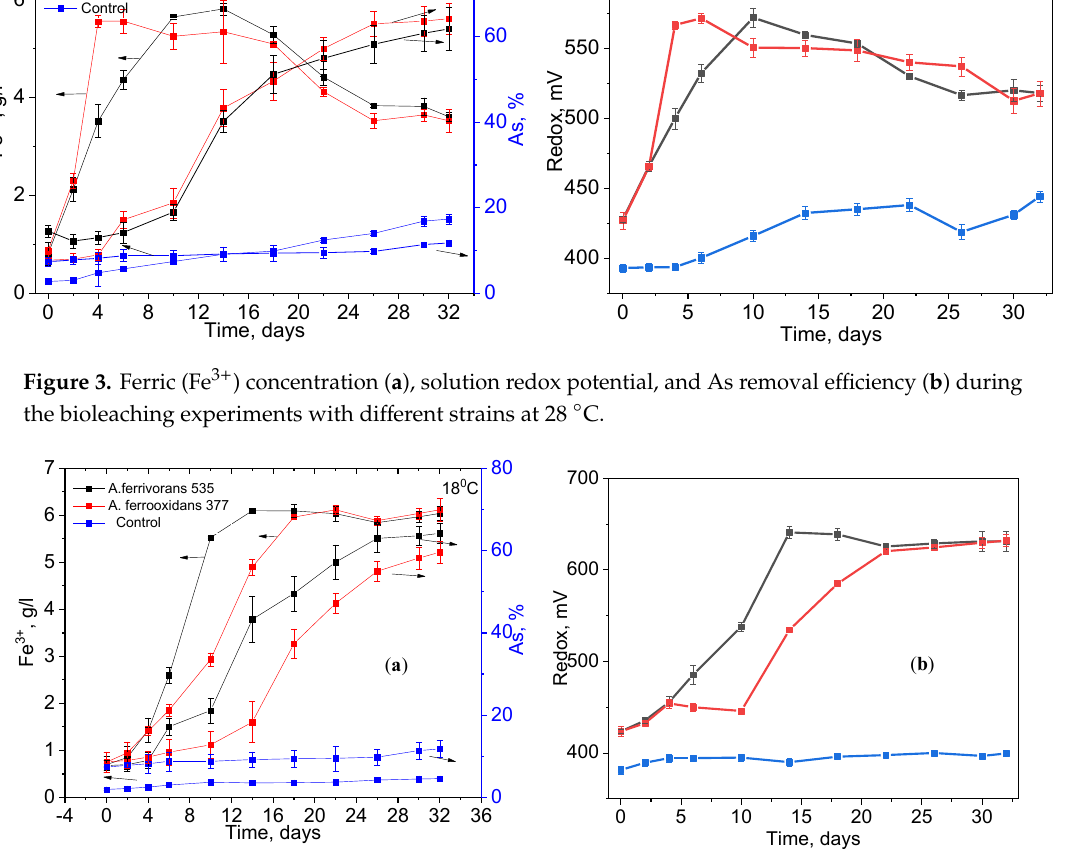
Figure 4. Ferric (Fe 3+ ) concentration ( a ), solution redox potential, and As removal efficiency ( b ) during the bioleaching experiments with different strains at 18 °C.